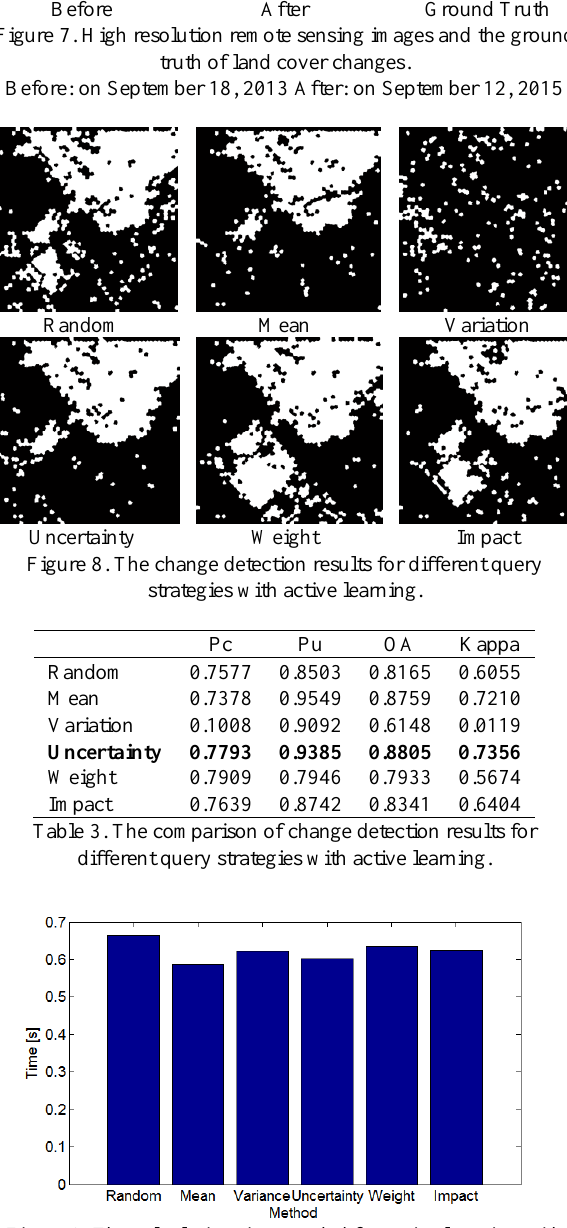
Figure 9. The calculation time needed for active learning with Gaussian